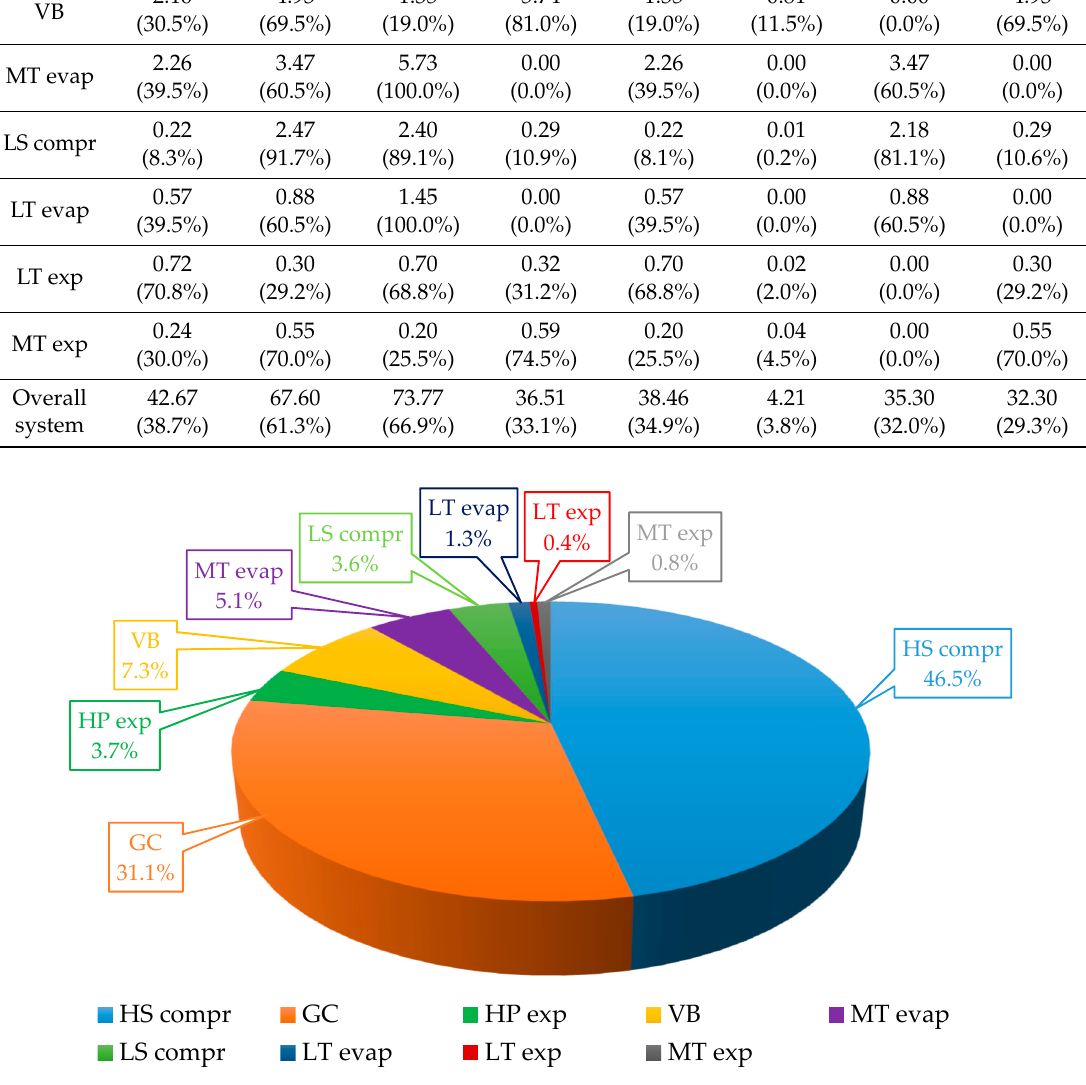
Figure 5. Breakdown of the contribution (%) of each component belonging to CB to the total avoidable exergy destruction rate at the outdoor temperature of 40 °C.